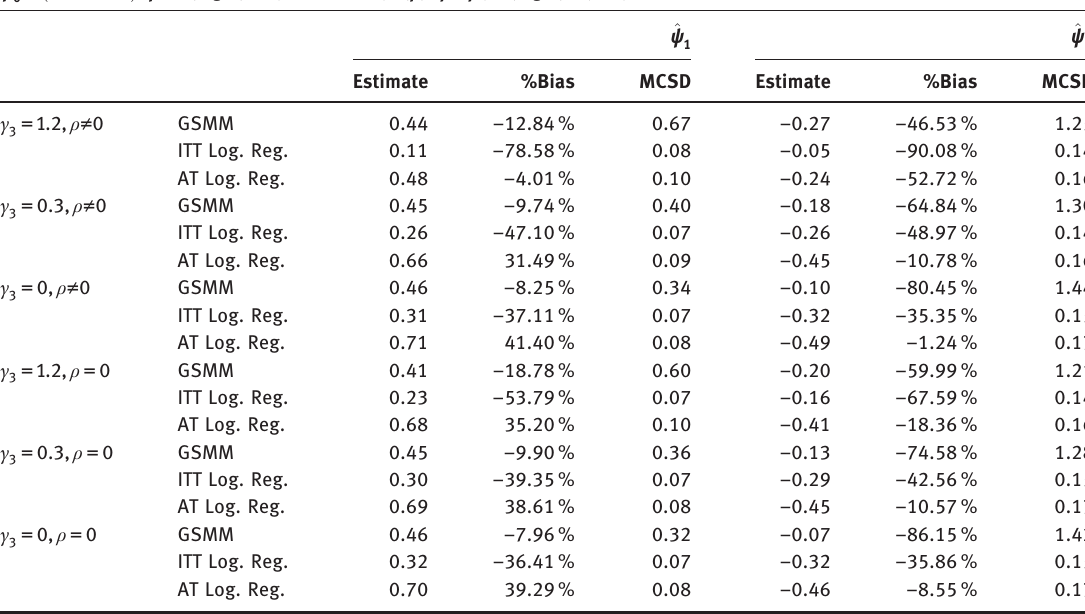
Table 3: Simulation study results. Mean estimates, percent bias, and Monte Carlo standard deviations of the modified G-estimation and standard logistic regression when nonignorable noncompliance is present and baseline covariates are weakly predictive of post-baseline effect modifier. ρ X characterizes the association between baseline covariates X , and ð γ characterize the association of X i and S . γ is the coefficient of A in the data-generating model for S . ρ =0 indicates that S does 3 not predict Y 0 . The first row in each parameter configuration corresponds to the G-estimation; the second row reports estimates from the intent-to-treat logistic regression; the third row is the as-treated logistic